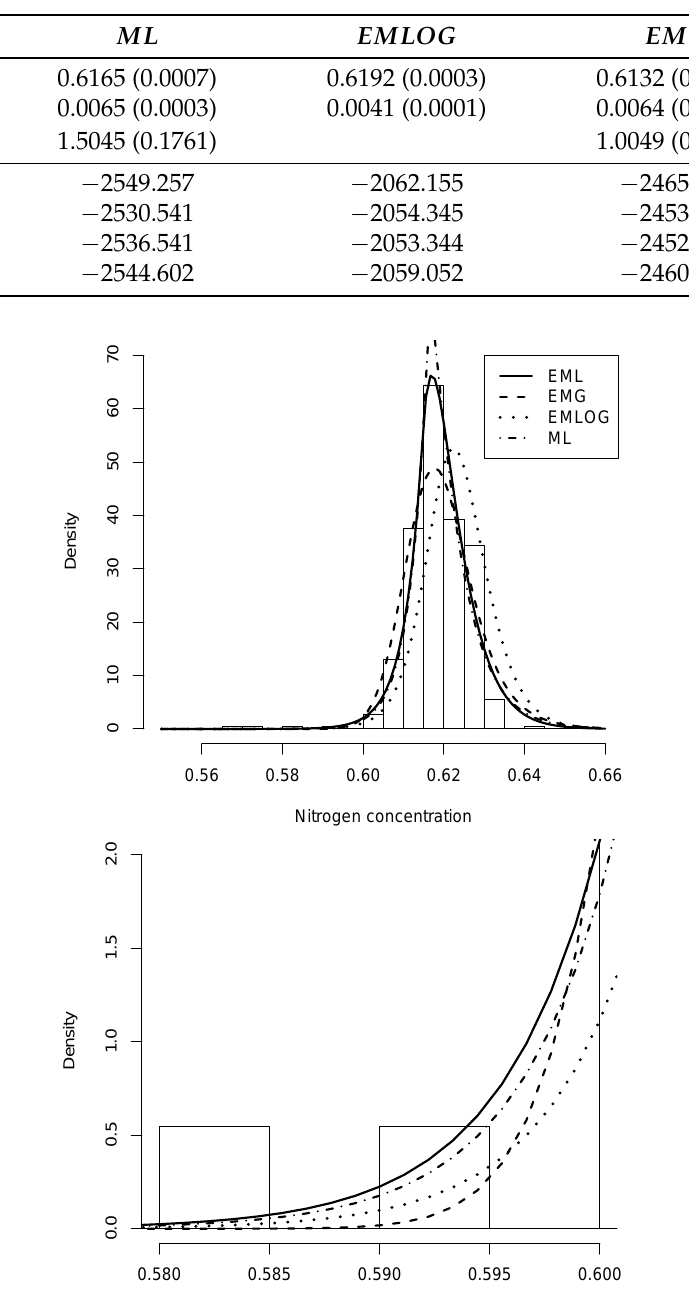
Table 9. Comparison of the maximum likelihood estimators for nitrogen concentration data between the ML , EMLOG , EMG , and EML distributions with their corresponding standard deviations in parentheses and comparison criteria AIC, BIC, CAIC and HQIC.